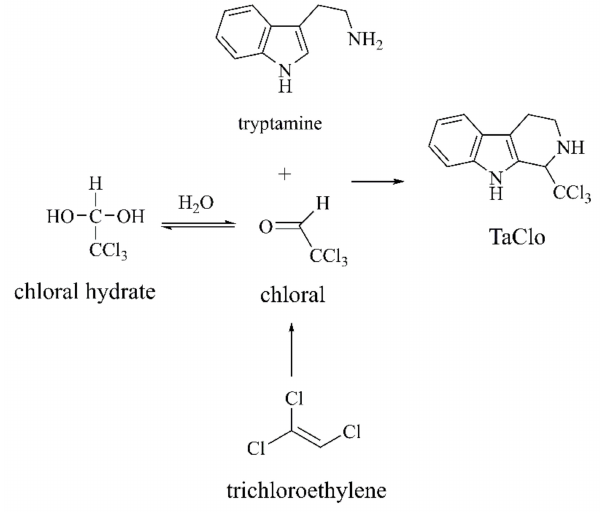
Figure 11. Condensation of tryptamine with chloral to form TaClo